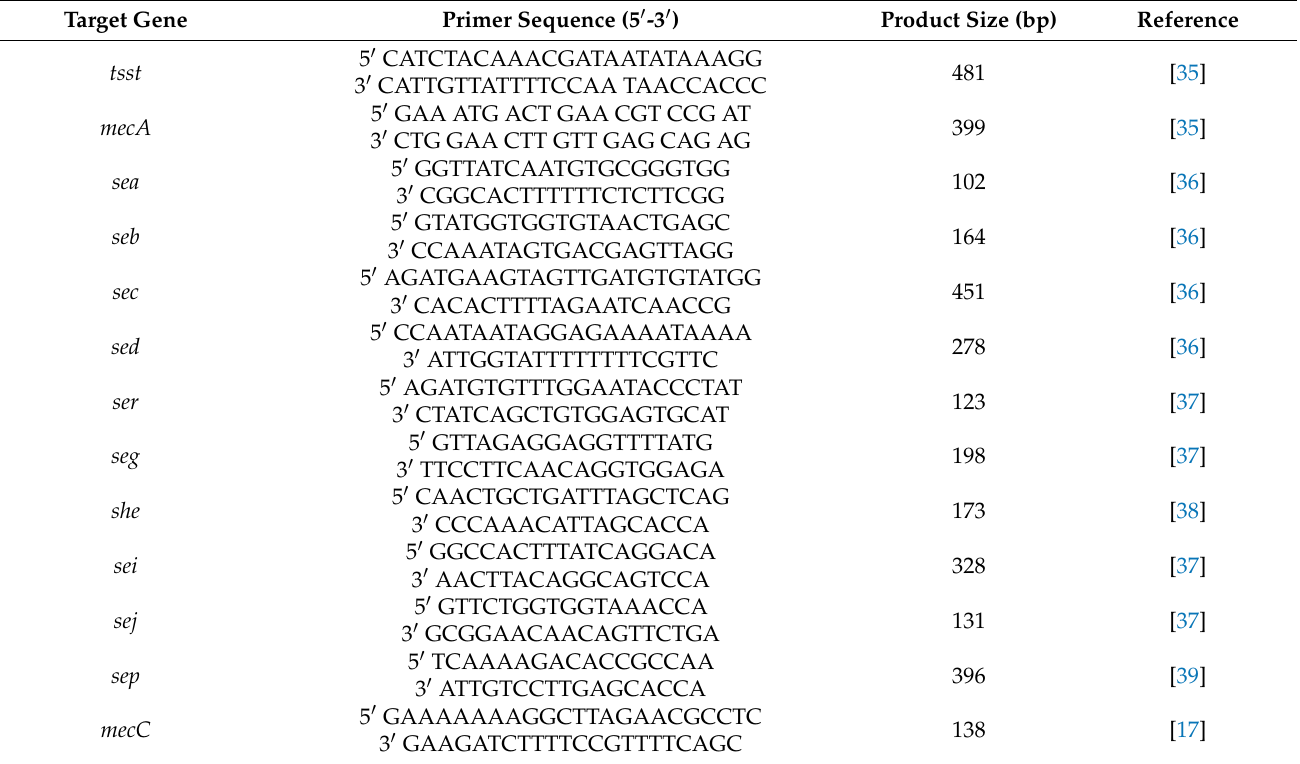
Table 1. Oligonucleotide sequence primers used to target genes for species confirmation in S. aureus . Target Gene Primer Sequence (5 (cid:48) -3 (cid:48) ) Product Size